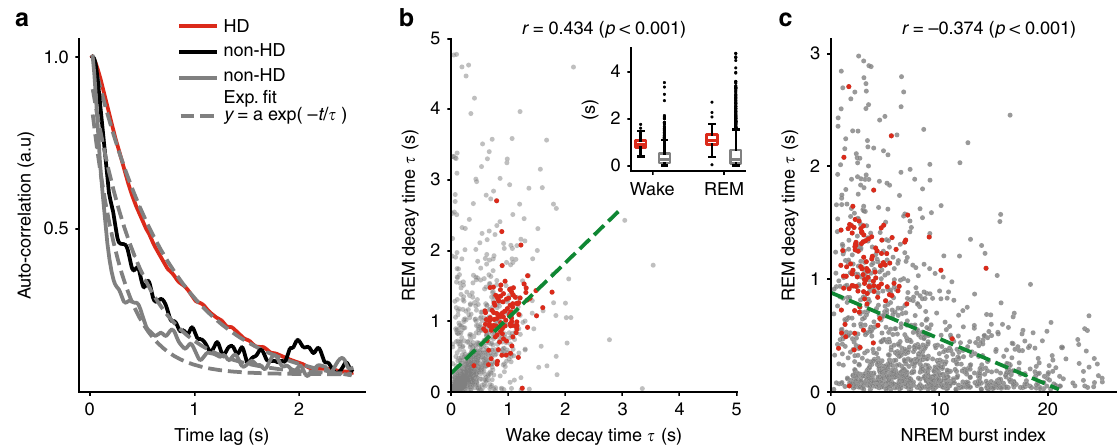
Fig. 6 Intrinsic slow dynamics during wakefulness and REM sleep in the AT and its relation to fast dynamics during NREM sleep. a Auto-correlograms of three neurons (HD and non-HD neurons) over long timescale (2.5 s) during wake. Dashed gray lines display exponential fi t. b Decay time τ between wake and REM sleep. Red dots indicate HD neurons. Inset shows average (±s.e.m.) decay time for HD and non-HD neurons during wakefulness and REM sleep. c Decay time τ during REM sleep as a function of burst index during NREM sleep ( r = − 0.374, p < 0.001, Pearson ’ s correlation). HD cells and non-HD cells are indicated by red and dark dots,